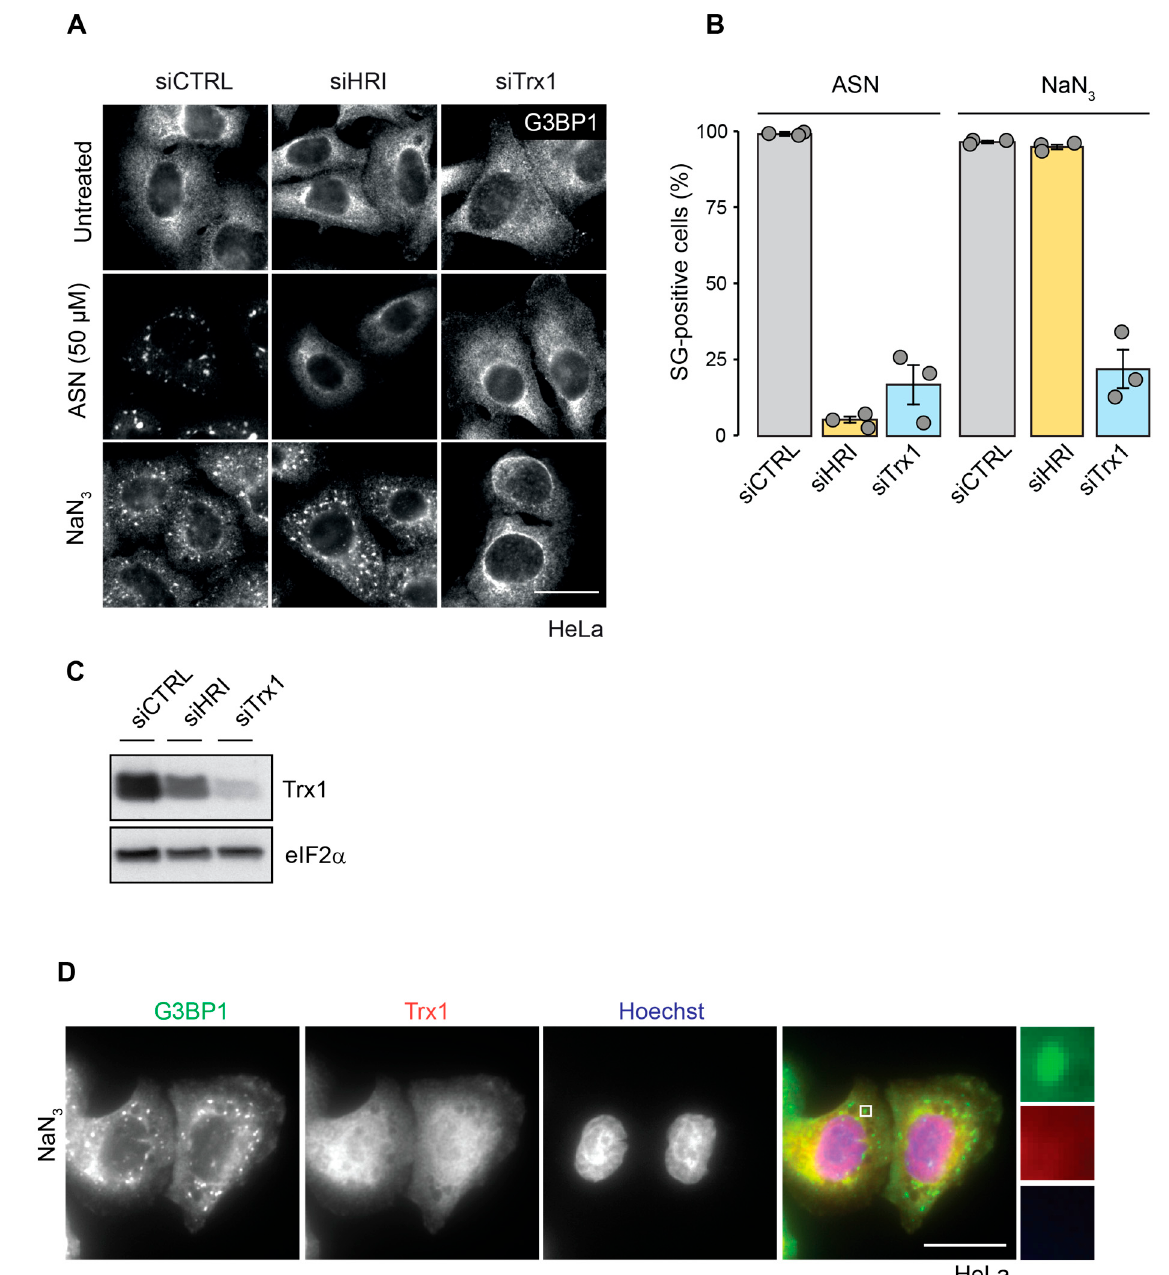
Figure 6. Trx1 is required for the formation of SGs under NaN 3 -induced stress. ( A ) HeLa cells were transfected with the non-targeting control siRNA, or an siRNA targeting HRI, or Trx1 for 72 h, treated with 50 µM ASN for 1 h, or 76 mM NaN 3 for 2 h, and prepared for IF microscopy; Scale bar = 20 µ m. ( B ) Quantification of A. The graph shows the mean value ± SD ( n = 3 independent experiments; approximately 100 cells were analyzed per experiment and condition). ( C ) Knockdown of Trx1 was assessed with a WB analysis; eIF2 α served as loading control. ( D ) HeLa cells were treated with 50 µ M ASN for 1 h or 76 mM NaN 3 for 2h. Fixed cells were stained with anti-G3BP1 and anti-Trx1 antibodies for IF microscopy. Hoechst staining was used for the detection of nuclei; Scale bar = 20 µm.